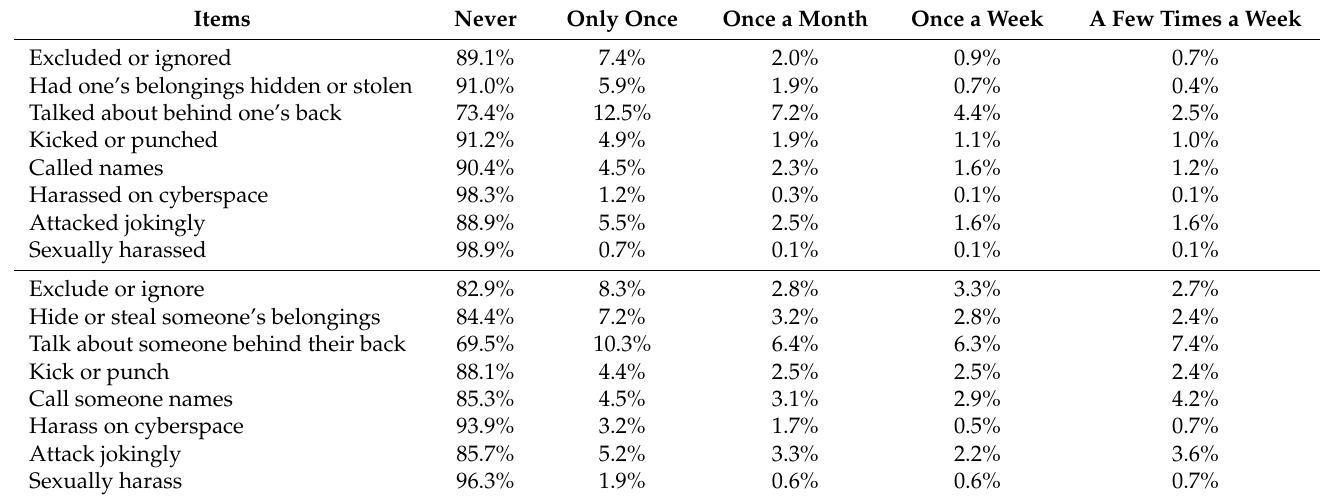
Table 1. Frequency of victimization and bullying